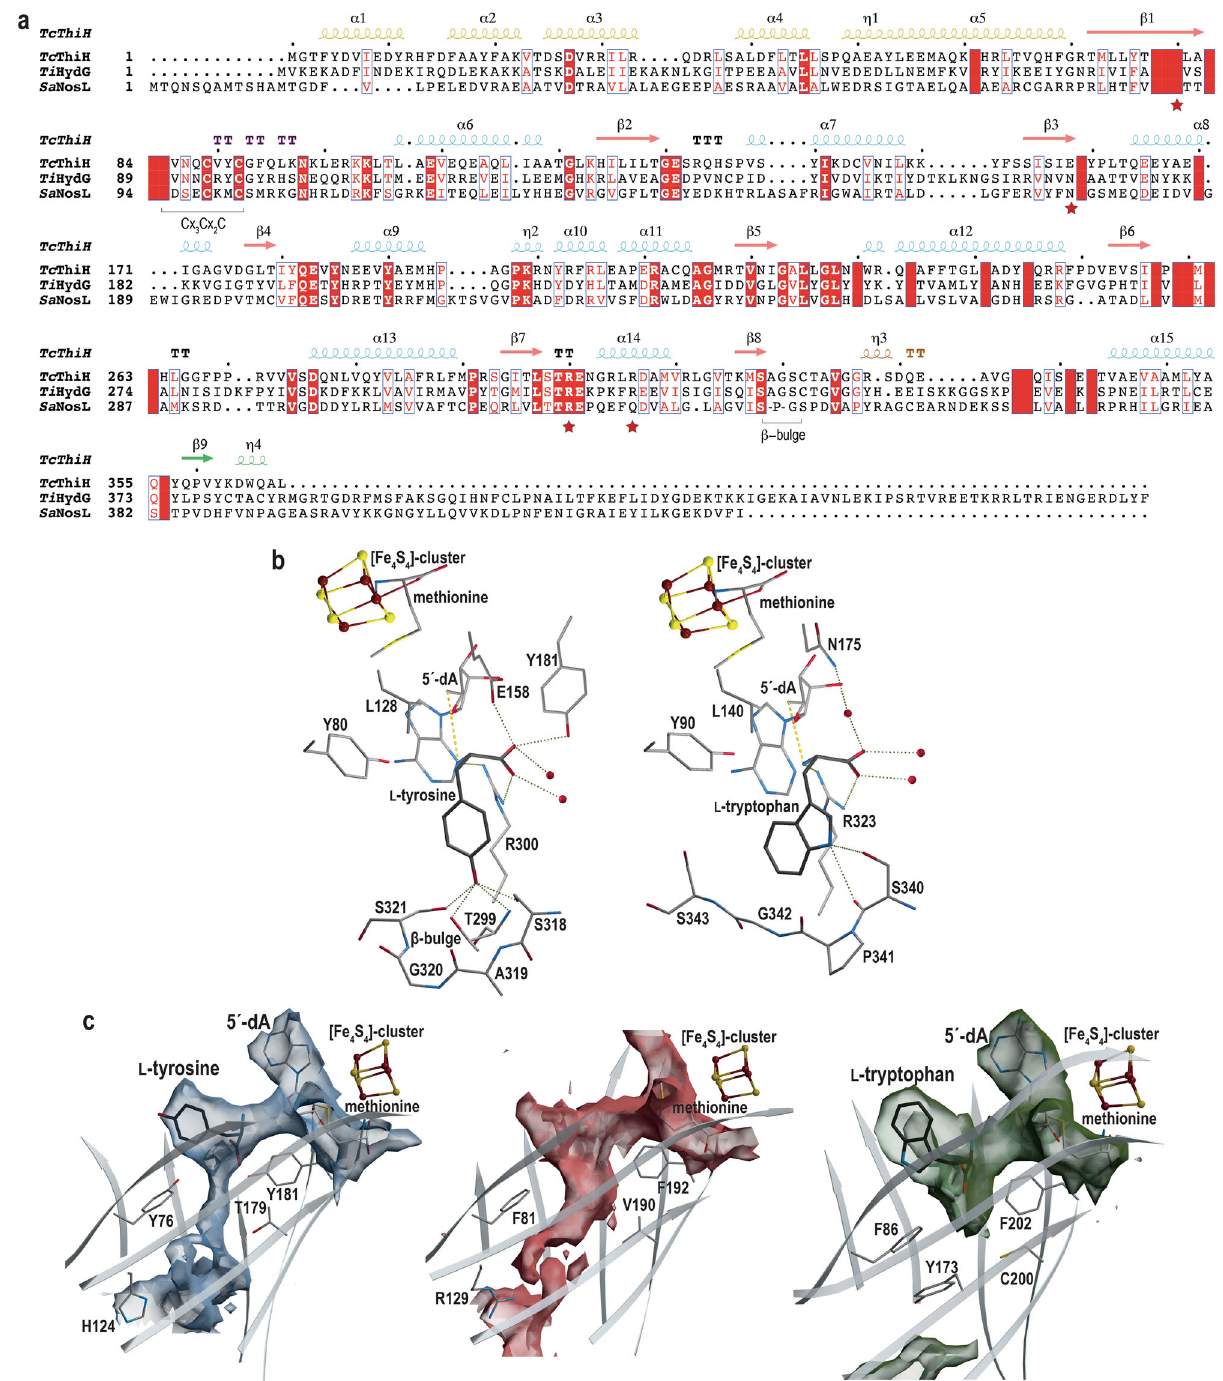
Fig. 3 Comparison Tc ThiH with Ti HydG and Sa NosL. a Multiple sequence alignment of Tc ThiH, HydG from Thermoanaerobacter italicus ( Ti ) and Sa NosL primary structures. Red and white boxes indicate conserved and similar amino acids in the three proteins. Tc ThiH secondary structure elements are depicted on top following the same color code as in Fig. 2a. Red stars highlight residues 80, 158, 300 and 306 that are discussed in the text. b L-tyrosine (left) and L-tryptophan (right) binding mode in Tc ThiH (this work) and Sa NosL 25 , respectively. Except for the [Fe 4 S 4 ] cluster depicted in the ball-and-stick form, the rest of the active site and the substrate are represented as sticks and water molecules are indicated as red spheres. C, N, O, S and Fe atoms are represented in light gray (dark gray for the substrates), blue, red, yellow and brown, respectively. c The cavity maps, contoured with an accessible probe radius of 1 Å, were calculated using the X-ray models of Tc ThiH (left, steel blue), Ti HydG 35 (center, ruby-red) and Sa NosL (right, olive color). When present in the structural model, 5´-dA, the L-methionine bound to the [Fe 4 S 4 ] cluster and the substrate were removed for the cavity calculation. Key residues and the [Fe 4 S 4 ] are represented as in ( b ). Stereoviews of ( b , c ), are presented in Supplementary Figs. 11, 12, respectively.